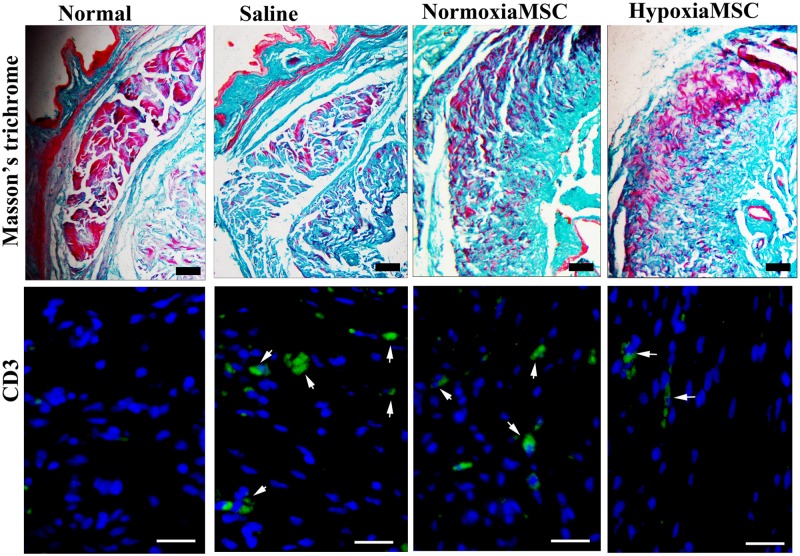
Histological analysis of collagen deposition and histochemical analysis of immune cell infiltration.Top panel: Masson’s trichrome staining to assess the collagen deposition which indicated tissue scarring (Scale bar: 100μm). Bottom panel: representative images of CD3-positive AMSCs (showed by white arrow) in corpus cavernosum of normal control rats (left) and diabetes induced ED rats receiving intracavernous injection with saline (middle left), N-AMSCs (middle right) and H-AMSCs (right). Immunostaining with anti-CD3 antibodies (cell surface markers of T lymphocytes) to assess inflammatory cell recruitment in injured tissue (DAPI staining, Scale bar: 25μm).